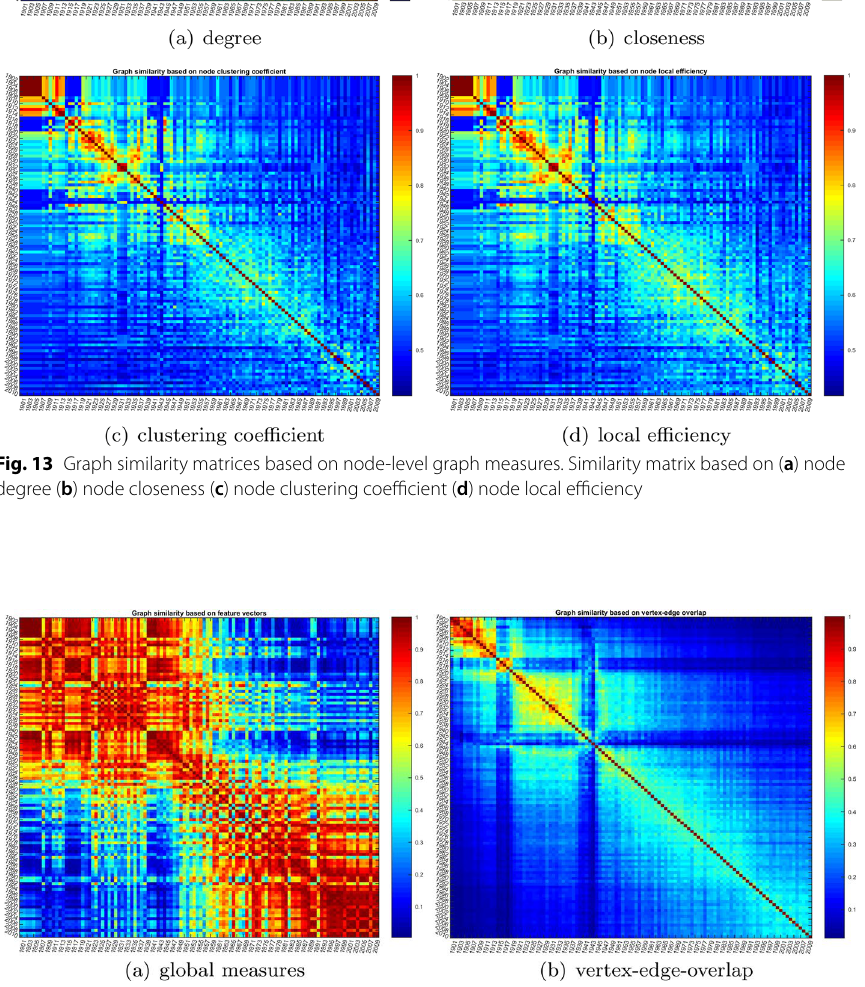
Fig. 14 Graph similarity matrices via global graph measures ( a ) and structural similarity ( b